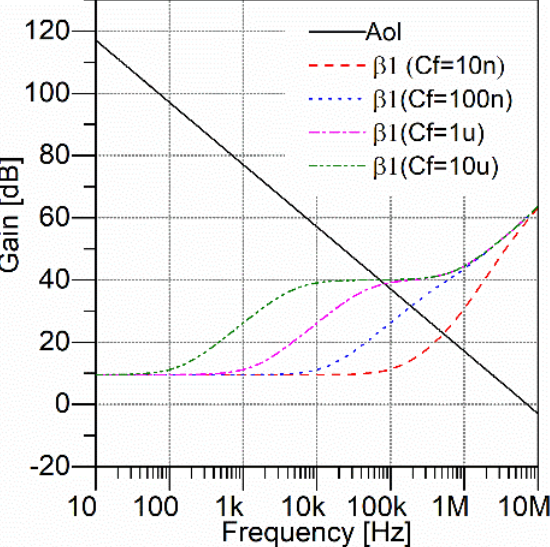
Figure 12. Amplitude-frequency characteristic curves of Aol and β 1 with different values of C5. In addition, it was found that the larger the capacitance, the more stable the circuit. However, the enhancement in stability was accompanied by a reduction in the output signal bandwidth. Therefore, considering the trade-off between circuit stability and signal bandwidth, the appropriate capacitance was finally determined to be 1 uF. Comparing the transient responses shown Figure 13 (capacitor C5 is added) and Figure 11 (capacitor C5 is removed), the effect of the compensation using C5 was